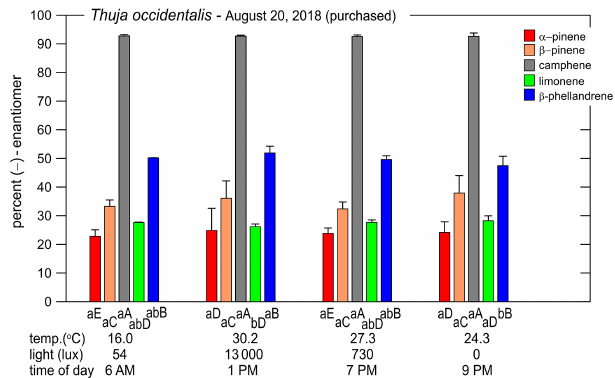
Figure 4. Percent of the ( − )-enantiomer for five monoterpenes in nursery-purchased samples of Thuja occidentalis on 20 Au- gust 2018. For a given time, the largest value is designated “A”; thereafter, a different capital letter indicates a significant difference between the monoterpenes. For a given monoterpene, the largest value is designated “a”; thereafter, a different lowercase letter indi- cates a significant difference between the times. The error bars are ± 1SD. The data values are given in Table 4.